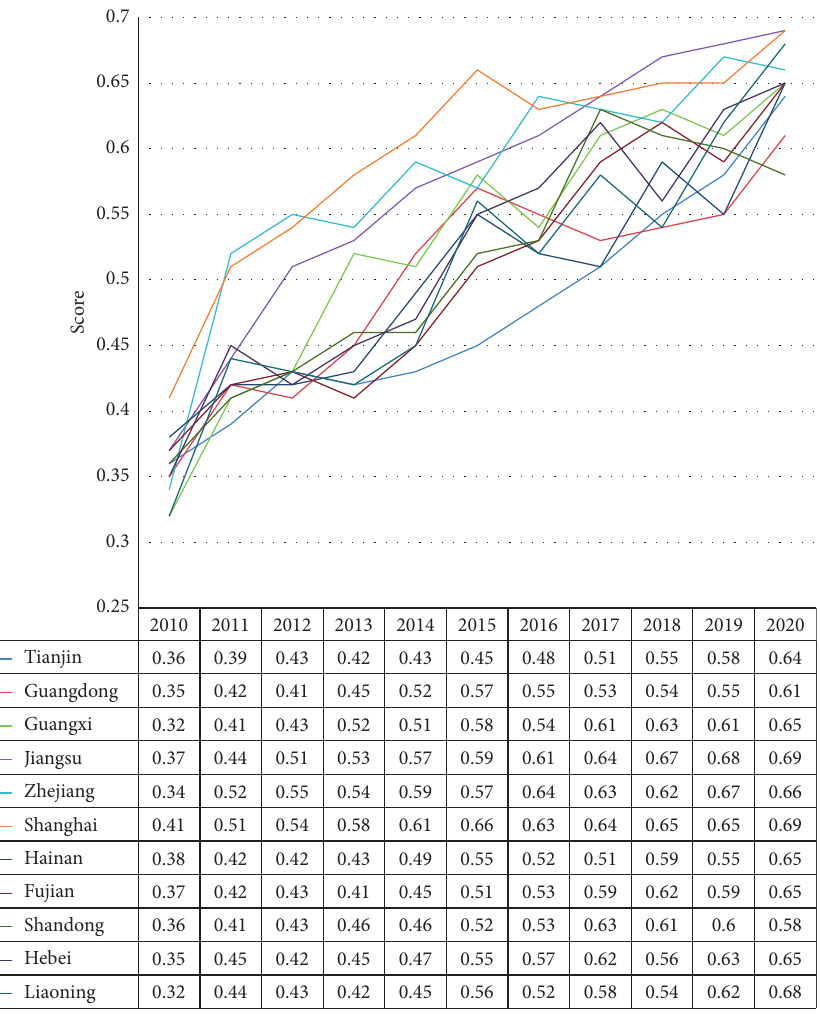
Figure 10: Composite scores of the complex system of coastal provinces in